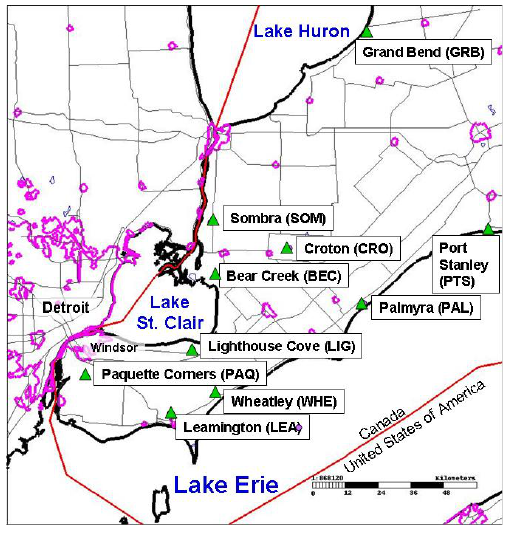
Fig. 3. Locations of BAQS-Met surface mesonet stations (green triangles). Urban region outlines in mauve, international border in